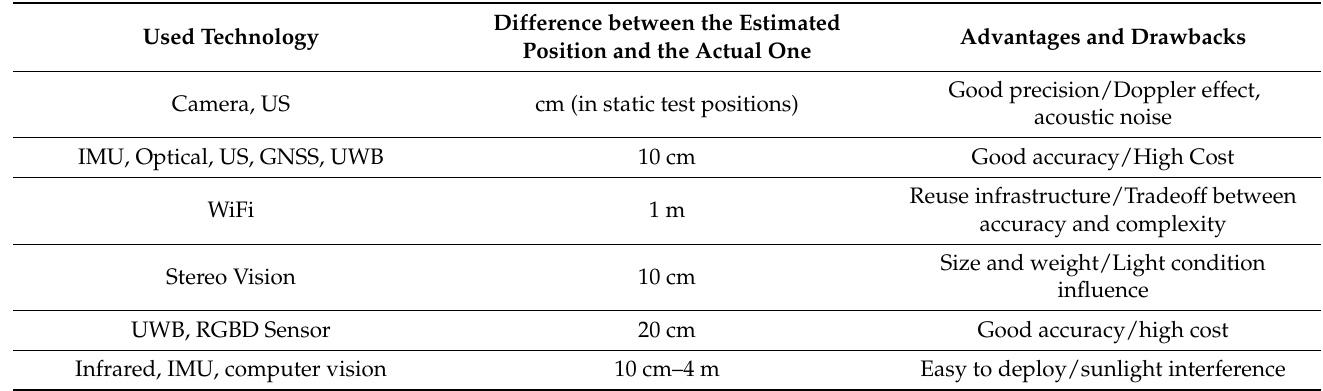
Table 1. Some indoor UAV location solution proposals